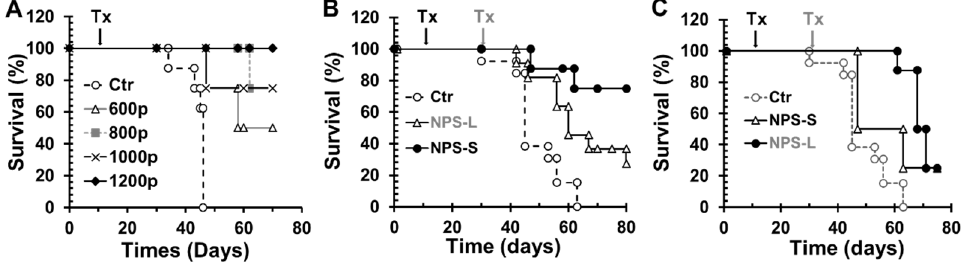
Figure 1. Kaplan-Meier survival curves of mice treated with NPS. Pan02 pancreatic tumors with the size of 4–7 mm (small) or 8–11 mm (large) were treated with NPS (200 ns, 30 kV/cm, 2 Hz with various pulses numbers) at day 11 or day 31 indicated by arrow. Ctr: mice with tumor but no treatment. ( A ) Dose response of NPS. 600p, 800p, 1000p or 1200p: treated with NPS with 600, 800, 1000 or 1200 pulses ( n = 4 each group). ( B ) Different efficacy of NPS for small or large tumors treated. NPS-S: small tumors treated with NPS 800 to 1200 pulses using pinch electrodes ( n = 8); NPS-L: large tumors treated with NPS 800 to 1200 pulses using needle electrodes ( n = 11). ( C ) Survival curves of animals with partial regression. NPS-S ( n = 4) or NPS-L ( n = 8).